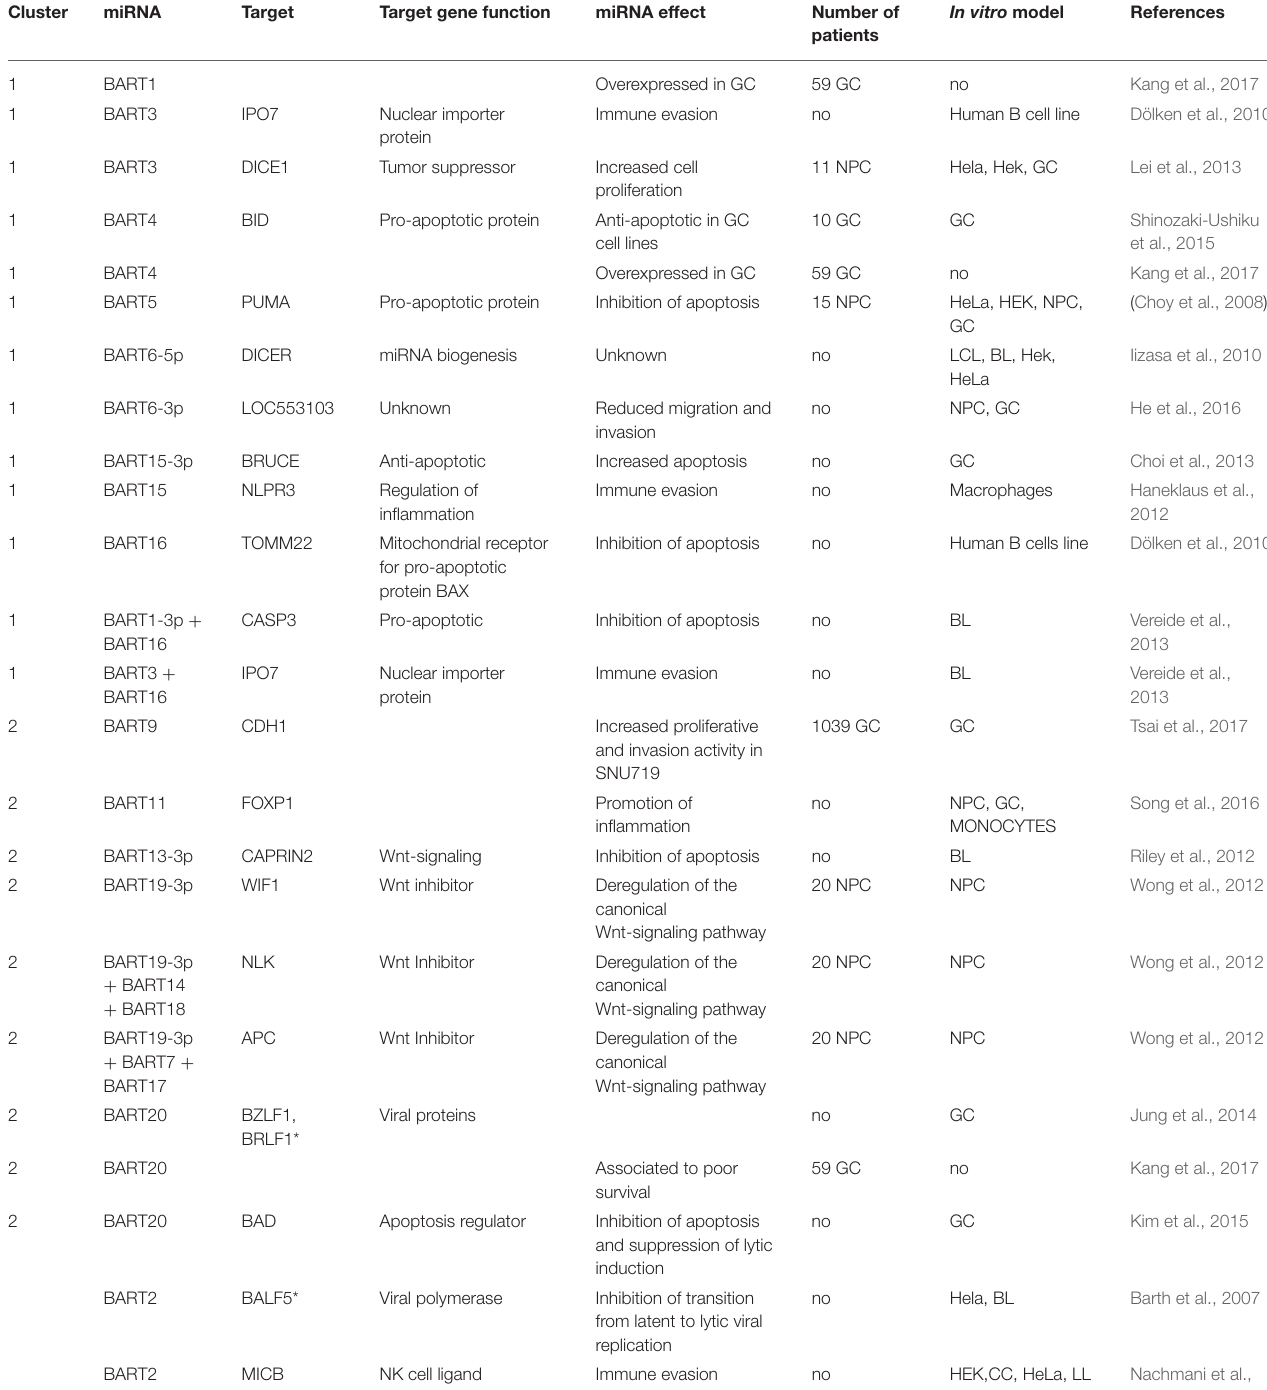
TABLE 2 | EBV miR-BARTs in EBV infected cells or tissues.